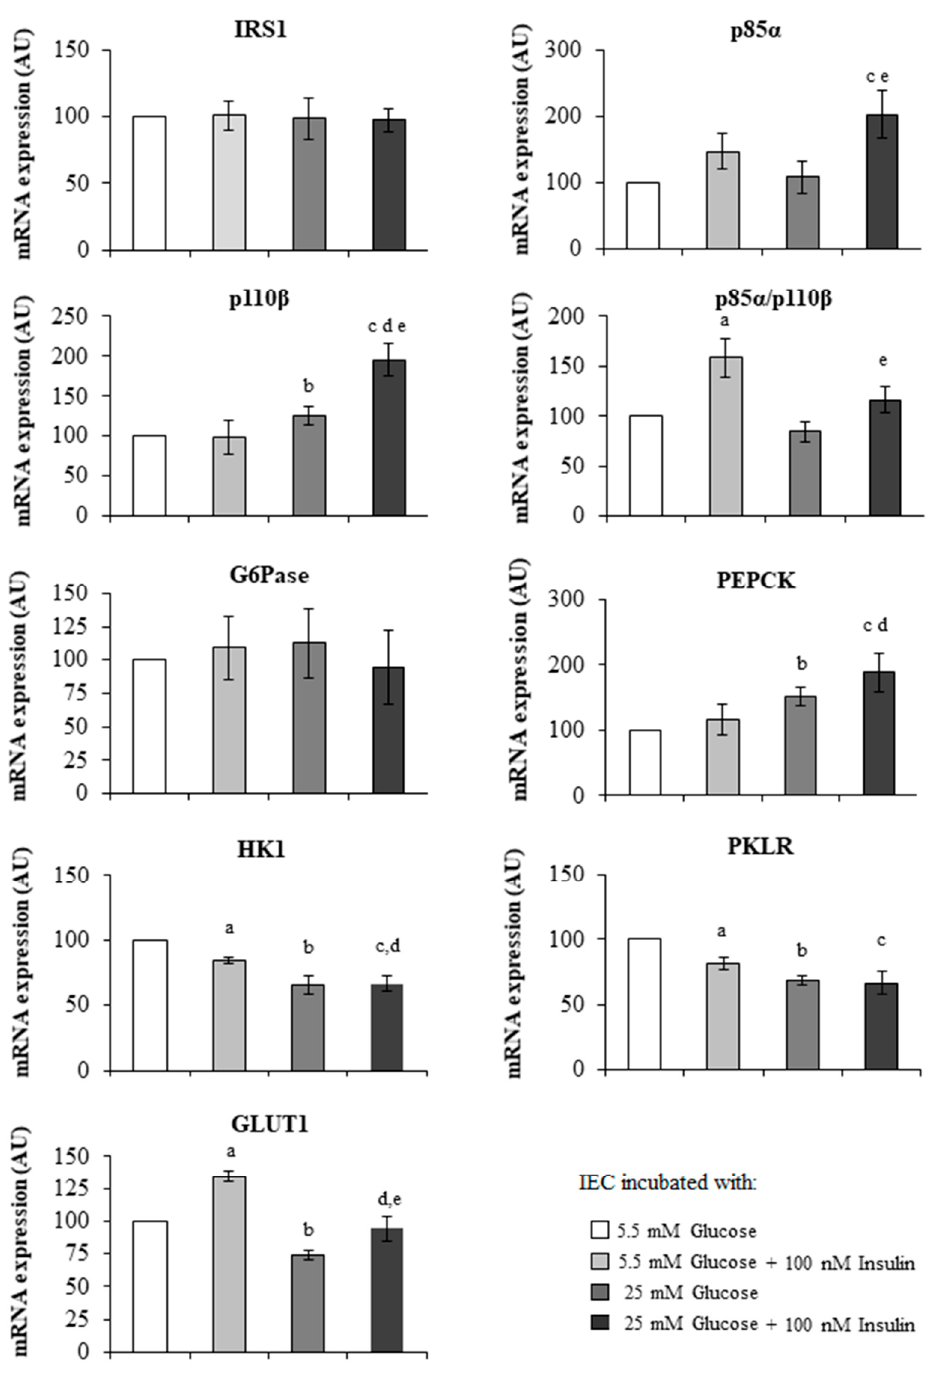
Figure 4. mRNA expression levels of studied genes in intestinal epithelial cells (IEC) incubations obtained from jejunum samples of MO-low-IR ( n = 6). IEC were isolated and incubated as described in the Material and Methods section. IEC were incubated with 5.5 mM glucose, 5.5 mM glucose + 100 nM insulin, 25 mM glucose, and 25 mM glucose + 100 nM insulin. The results were expressed as a percentage of 5.5 mM glucose level (100%). a Significant difference between 5.5 mM glucose and 5.5 mM glucose + 100 nM insulin ( p < 0.05). b Significant differences between 5.5 mM glucose and 25 mM glucose ( p < 0.05). c Significant differences between 5.5 mM glucose and 25 mM glucose + 100 nM insulin ( p < 0.05). d Significant differences between 5.5 mM glucose + 100 nM insulin and 25 mM